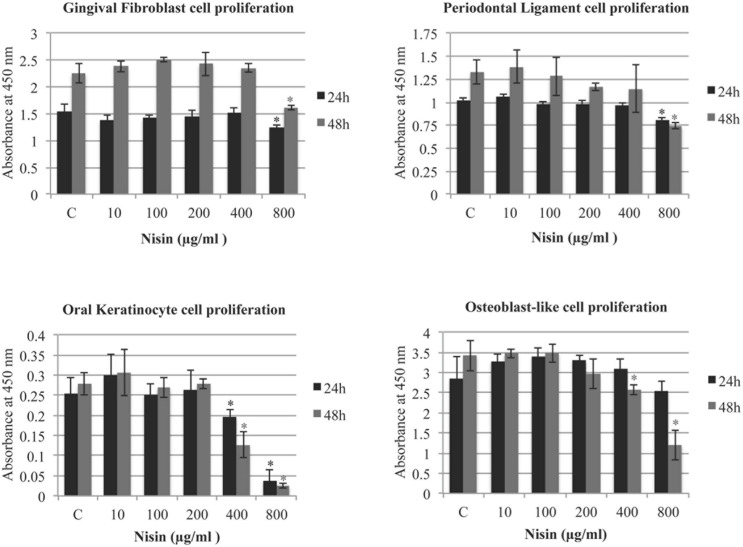
Nisin does not effect cell proliferation of human cells. The effect of nisin on cell proliferation was assessed using a Cell Counting Kit-8 measuring the lactate dehydrogenase (LDH) activities in cells. Using a 96-well microplate, GFs, PDL cells, OKs, and osteoblast-like cells were plated at 2 × 104 cells/cm2 and incubated for 24–48 h in the presence or absence of nisin (1–800 μg/ml). At 24 and 48 h time points, LDH levels were measured using absorption spectroscopy at 450 nm. Mean values were calculated with SD. ∗P < 0.05: significant differences from the control (nisin-free).